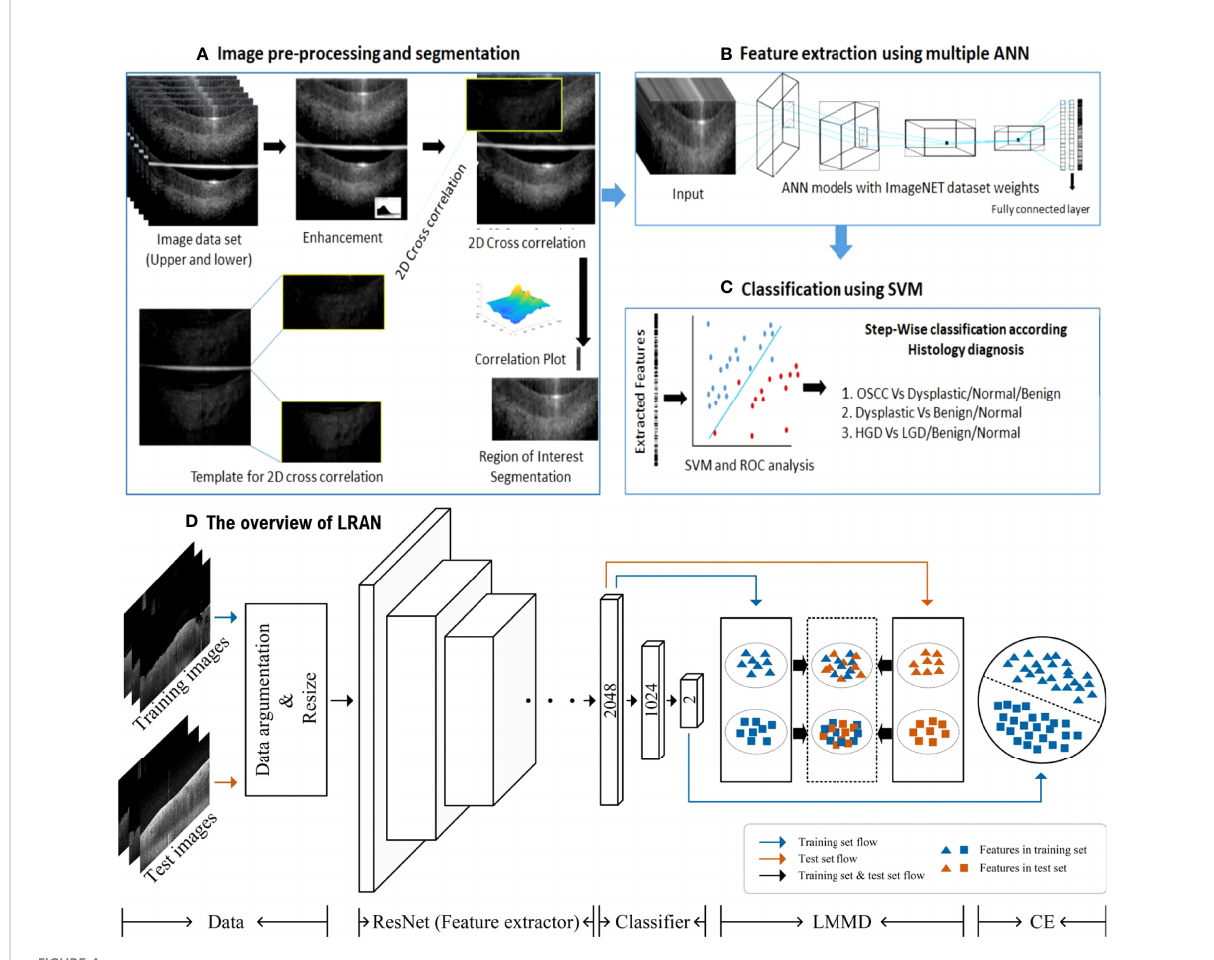
TABLE 1 The imaging capabilities of OCT in super fi cial tumors. Cancer Authors Main Findings Cutaneous Von Knorring et al. (2022) (54); Schuh melanoma et al. (2022) (55) Cutaneous basal cell